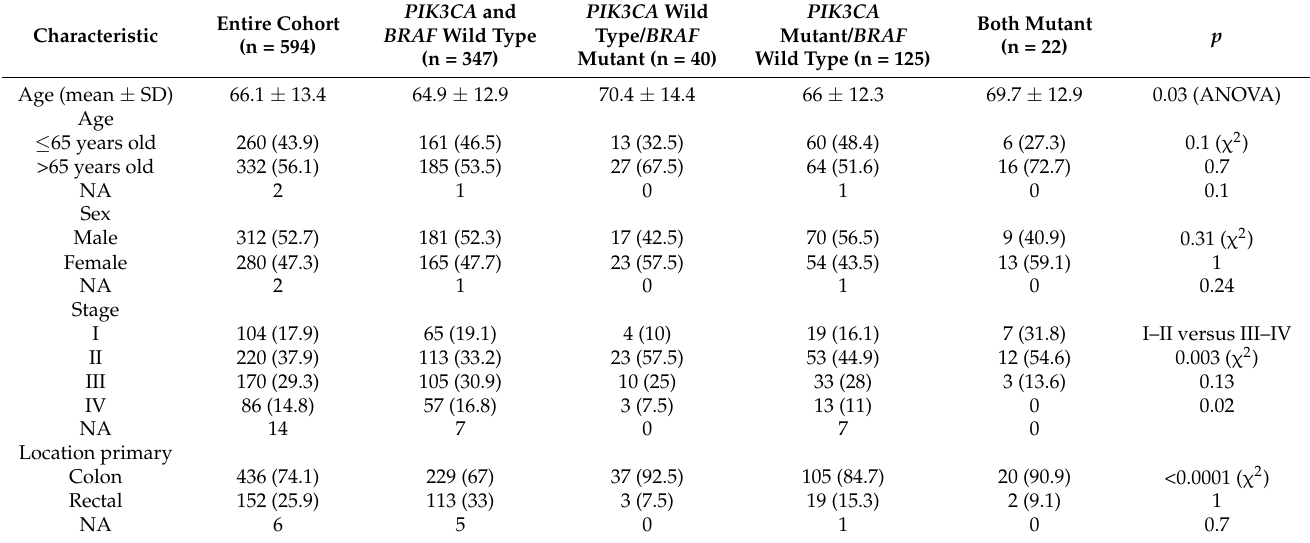
Table 1. Characteristics of colorectal cancers with and without PIK3CA and BRAF mutations in the TCGA cohort. Two patients are missing demographic data. Analysis for PIK3CA and BRAF mutations was performed in 534 patient samples. NA: not available. The p values presented in the last column refer to Fisher’s exact test except if stated otherwise. For each categorical characteristic, three comparisons are presented. The first includes all four groups (group with both PIK3CA and BRAF wild type, group with PIK3CA wild type and BRAF mutant, group with PIK3CA mutant and BRAF wild type, and group with both PIK3CA and BRAF mutant), the second comparison is between double mutant cancers and cancers with BRAF mutations and wild type PIK3CA . The third comparison is between double mutant cancers and cancers with PIK3CA mutated and BRAF wild type. For cancer stage comparisons in the four mutation groups, early stages (I and II) and advanced stages (III and IV) were grouped together in the statistical analysis. The comparisons of various characteristics of interest involving all four mutation groups were performed with the χ 2 test. Comparisons involving two groups were performed with the Fisher’s exact test when the characteristic of interest had 2 categories and with the χ 2 test when the characteristic of interest had more than 2